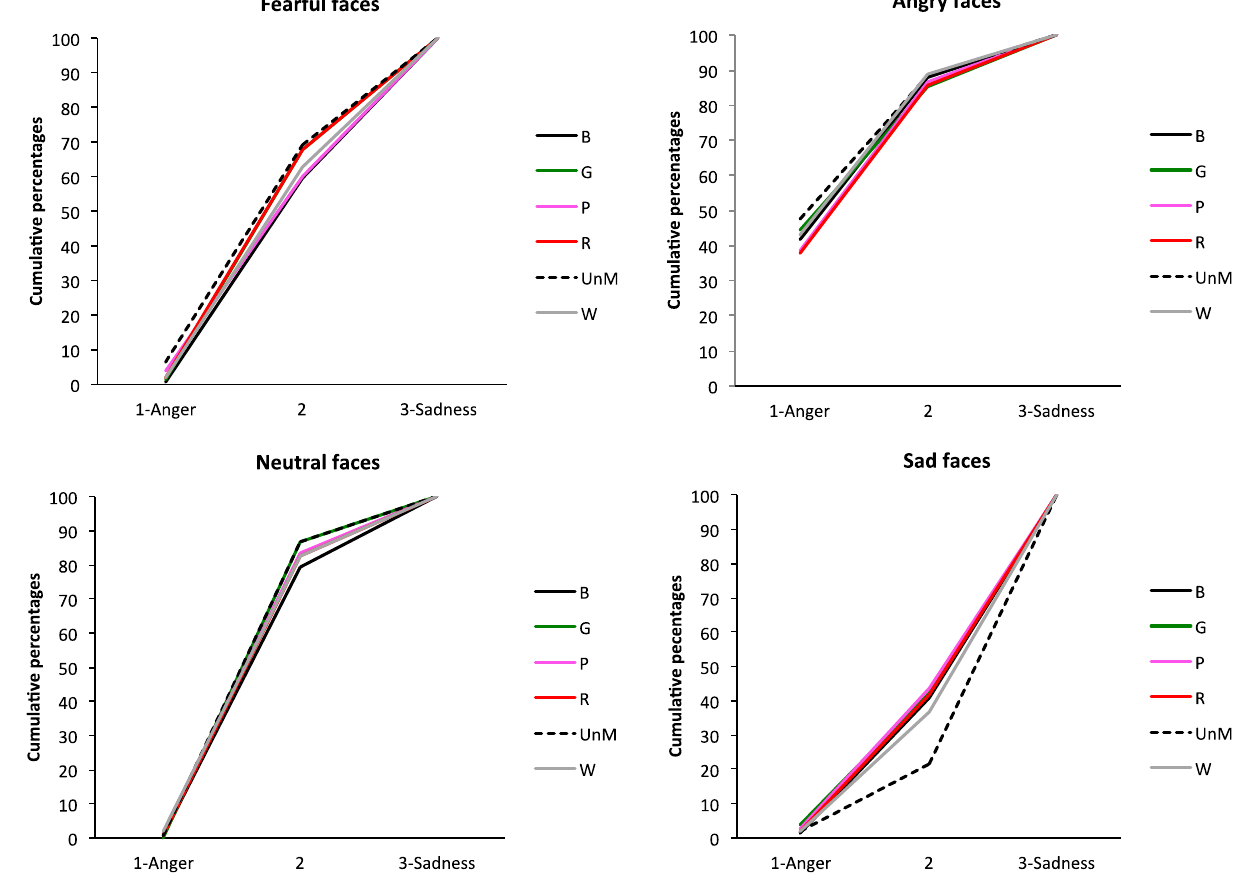
Figure 5. Cumulative percentages of the perception of each EFE for Scale 2, as a function of mask condition (faces wearing a B black, G green, P pink, R red, W white, mask; UnM unmasked